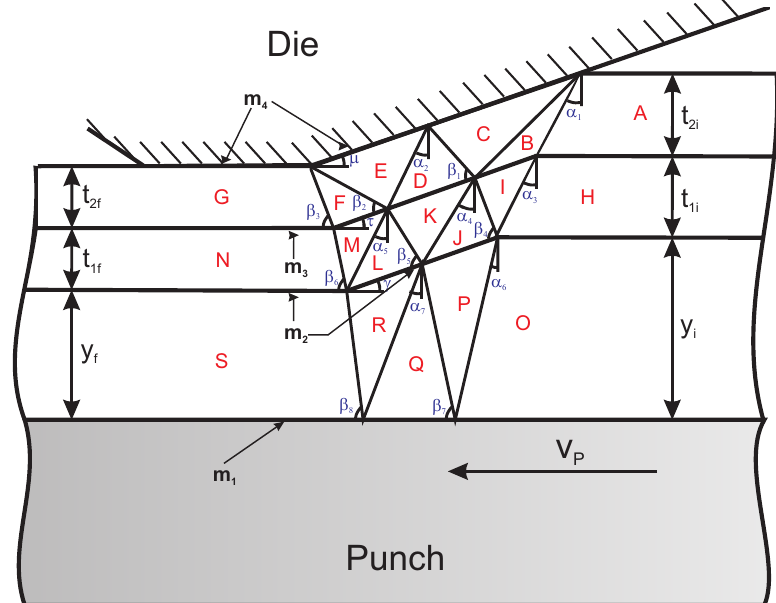
Figure 6. Illustration of the VDF for good ironing.